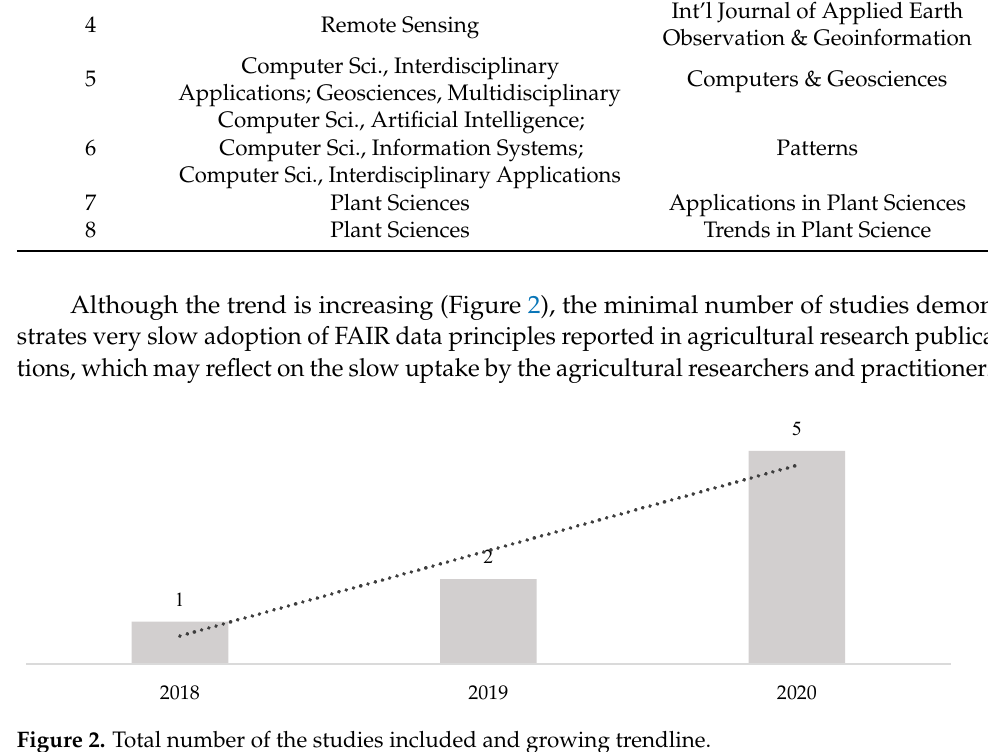
Table 3. Web of science categories and journals included.